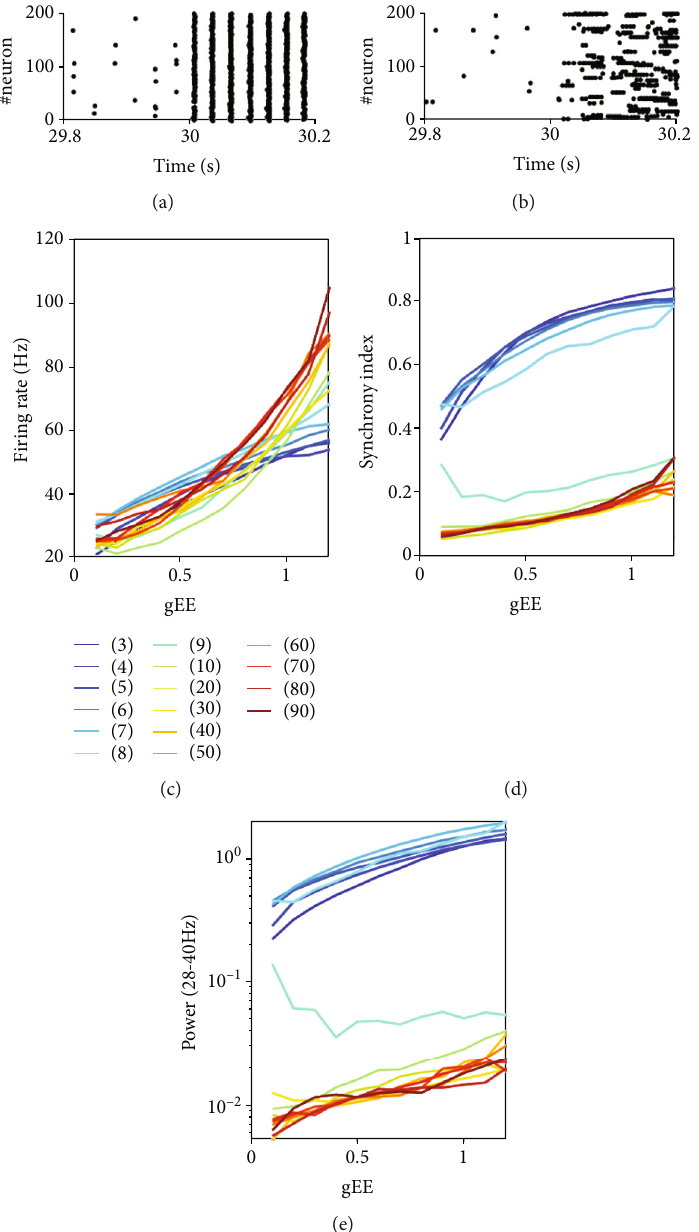
Figure 2: Dynamical properties of the circuits without plasticity. (a, b) Raster plot of the spiking time of 200 stimulated neurons (extra stimulation onset at = 30s for g EE = 0 : 1 . (a) Highly synchronous state with τ E properties with respect to synaptic strength during extra stimulus. The cases of di ff erent τ E τ E values corresponding to di ff erent colors are shown in the bar. (c) Network fi ring rate. (d) Synchrony index. (e) Gamma power. Other d = 8ms, As = 2 : 5 parameters are set as τ I d